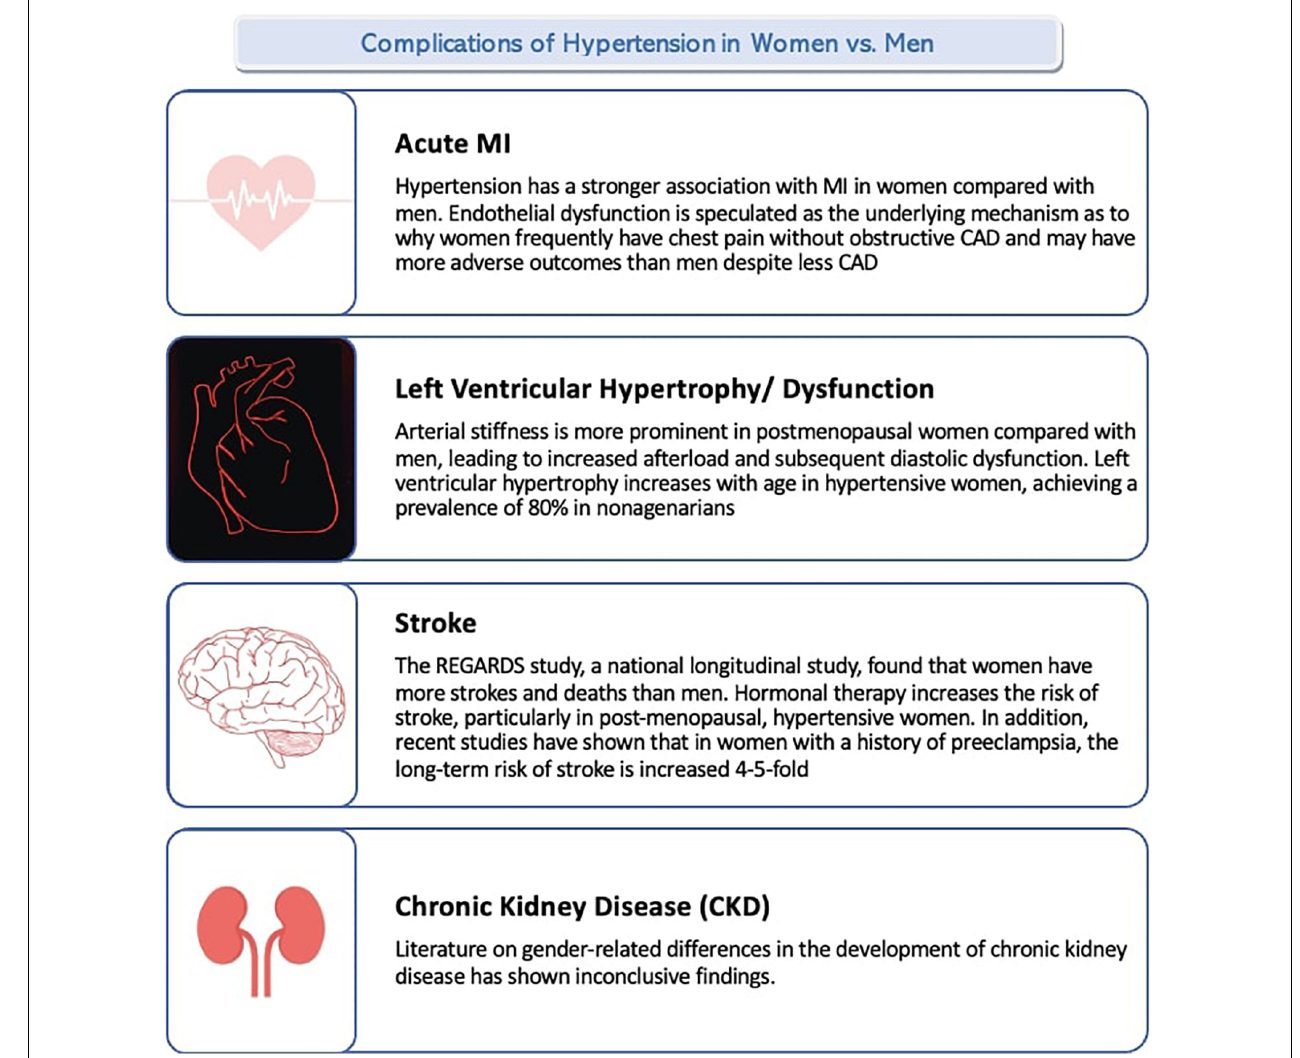
FIGURE 2 | Complications of hypertension in women vs.